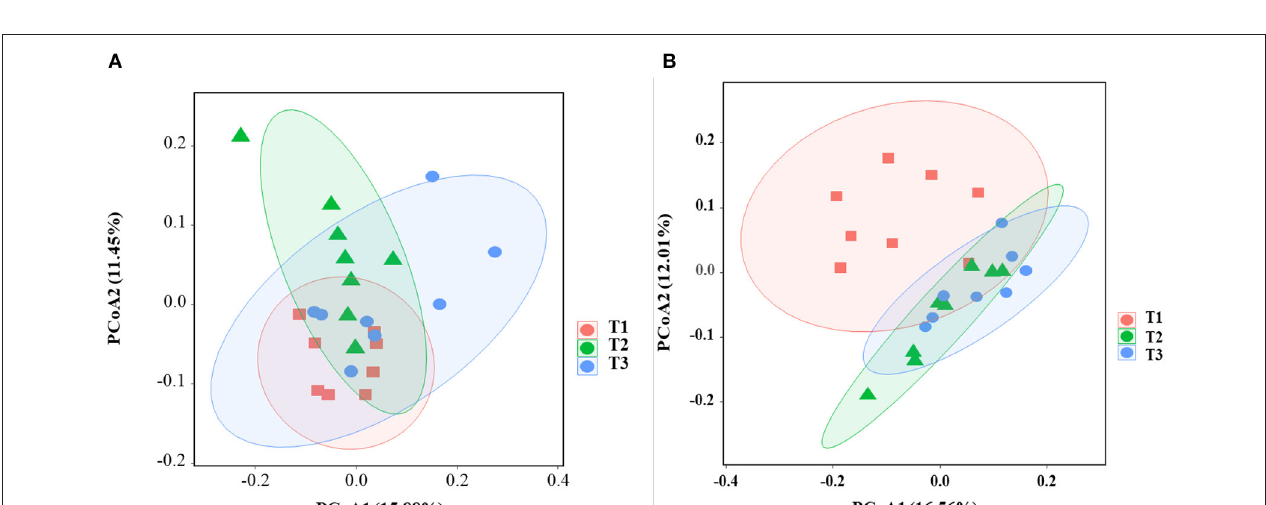
FIGURE 3 | Effects of dietary amylose/amylopectin ratio on alpha-diversity indices in the cecal mucosa and digesta (A) Chao 1 Index. (B) Shannon index. Diamond plot of richness and evenness diversity values showed that the microbiota structure of each group. Whiskers represent minimum and maximum value. Bottom and top of the box are the first and the third quartile. The median is shown as a band inside the box. T1 (normal corn 100%, high amylose corn 0%); T2 (normal corn 50%, high amylose corn 50%); T3 (normal corn 0%, high amylose corn 100%).